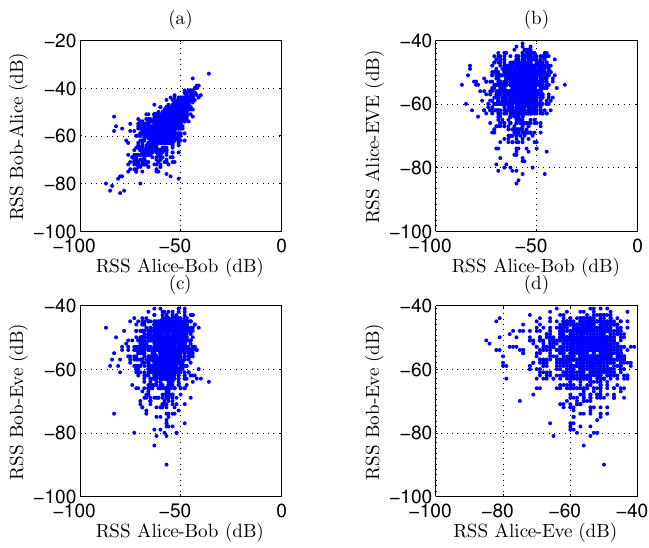
Figure 6. Scatterplots for 1500 recorded RSS channel samples in scenario 7, displaying slightly reduced correlation for the legitimate parties and very low correlation for the eavesdropper. ( a ) Correlation for Bob-to-Alice versus Alice-to-Bob signals; ( b ) Correlation for Alice-to-Eve versus Alice-to-Bob signals; ( c ) Correlation for Bob-to-Eve versus Alice-to-Bob signals; ( d ) Correlation for Bob-to-Eve versus Alice-to-Eve